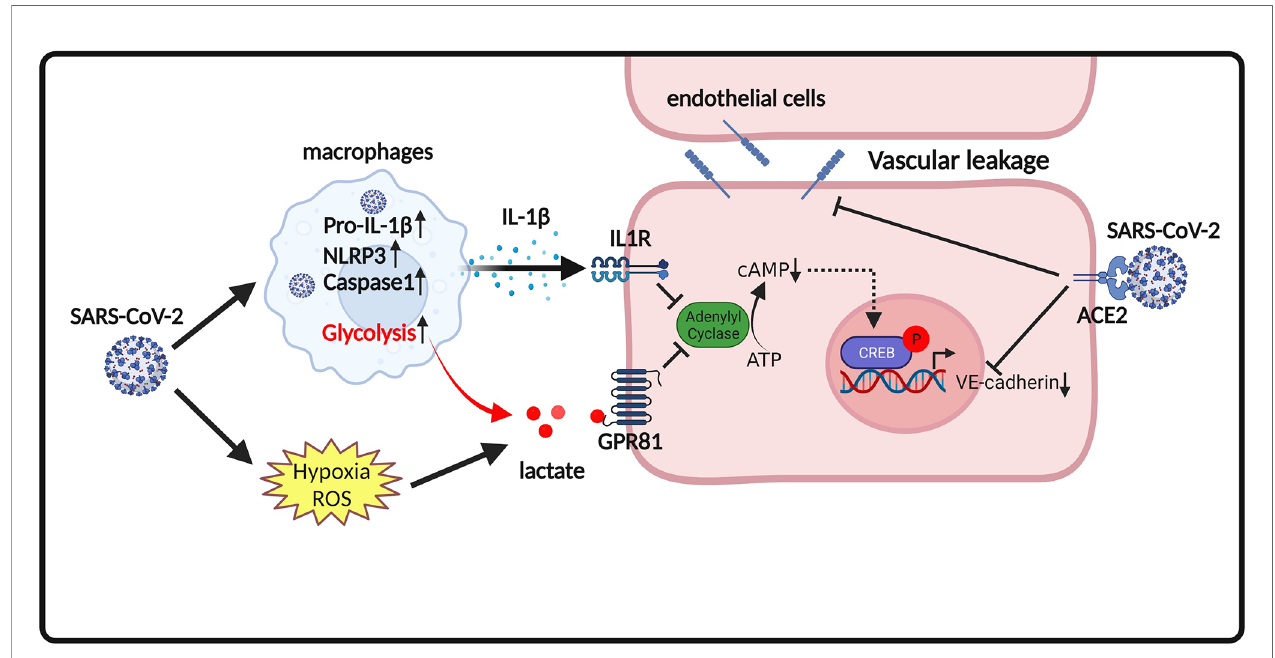
FIGURE 2 | Proposed model of endothelium permeability induced by lactate/GPR81 signaling and SARS-CoV-2 infection. SARS-CoV-2 infection promotes the release of the pro-in fl ammatory cytokine IL-1 b . IL-1 b suppresses cAMP formation and CREB-mediated transcription of VE-cadherin in endothelial cells. SARS-CoV-2 infection also increases lactate production. Lactate activates GPR81 and reduces cAMP generation and CREB-mediated transcription of VE-cadherin in endothelial cells. In addition, SARS-CoV-2 spike proteins directly disorganize VE-cadherin complex and suppress VE-cadherin transcription in endothelial cells. Disruption of VE- cadherin complex is responsible for vascular permeability in